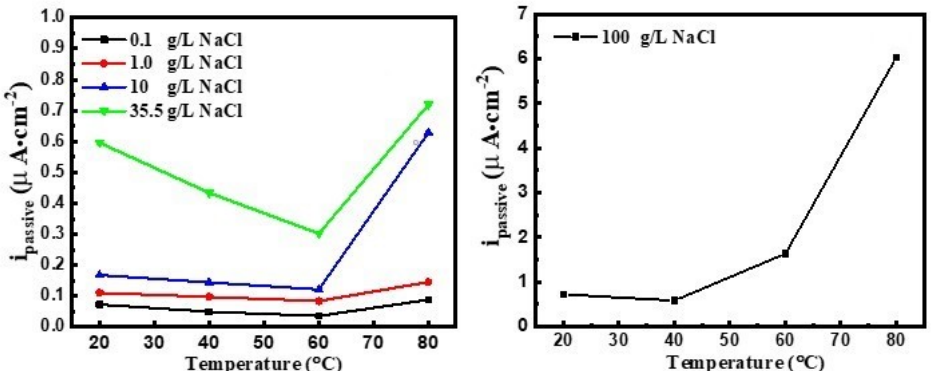
Figure 4. The average i passive values were derived from the potentiostatic experiment using variable concentrations of NaCl at elevated temperatures in a saturated CO 2 environment